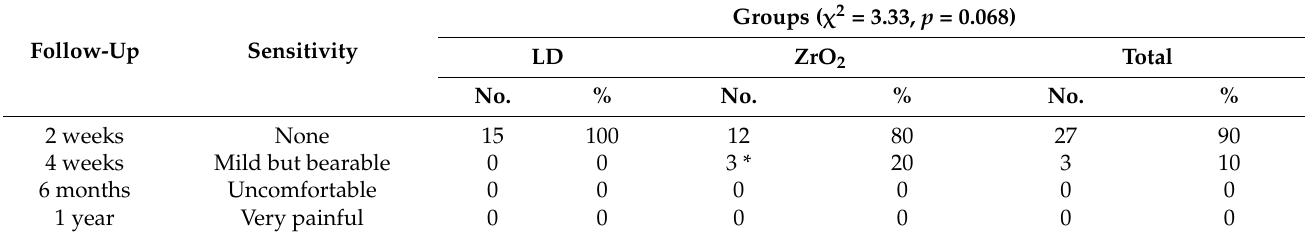
Table 10. The occurrence of sensitivity in the